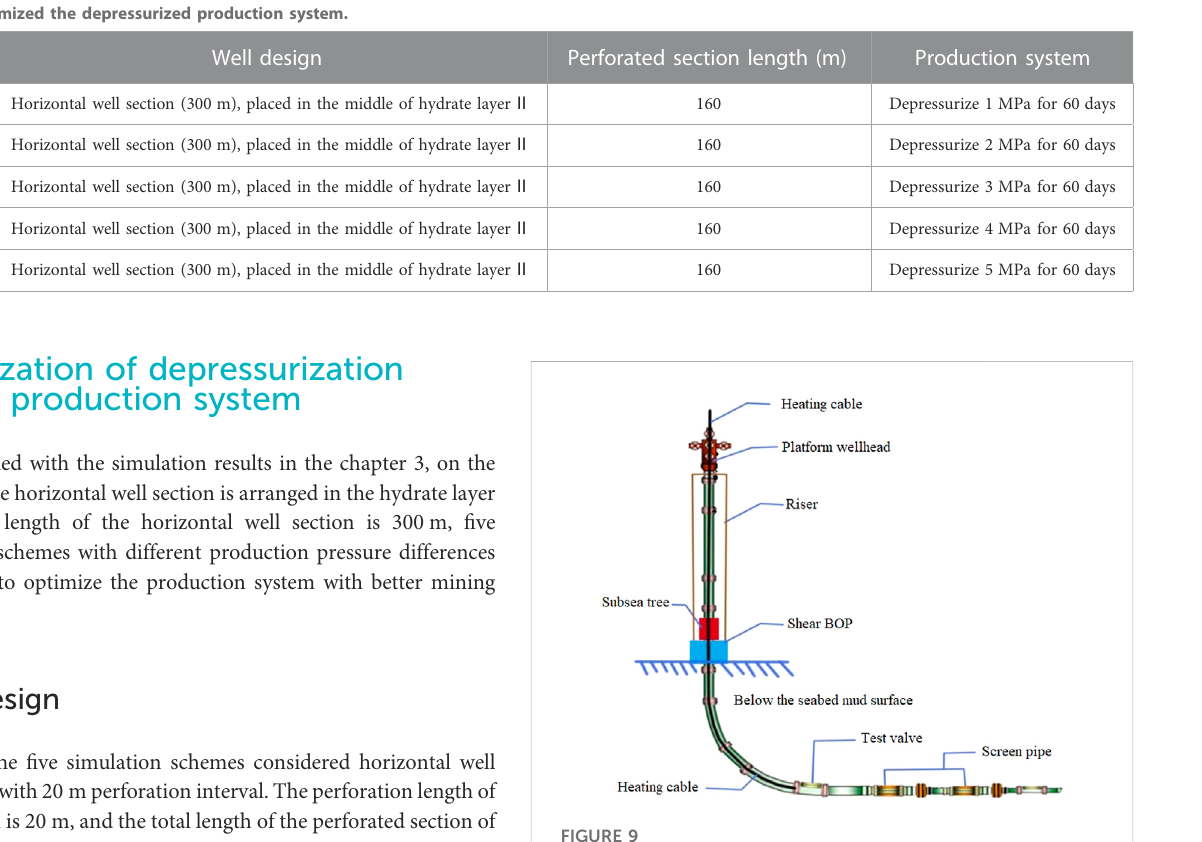
FIGURE 9 Schematic diagram of cable heating